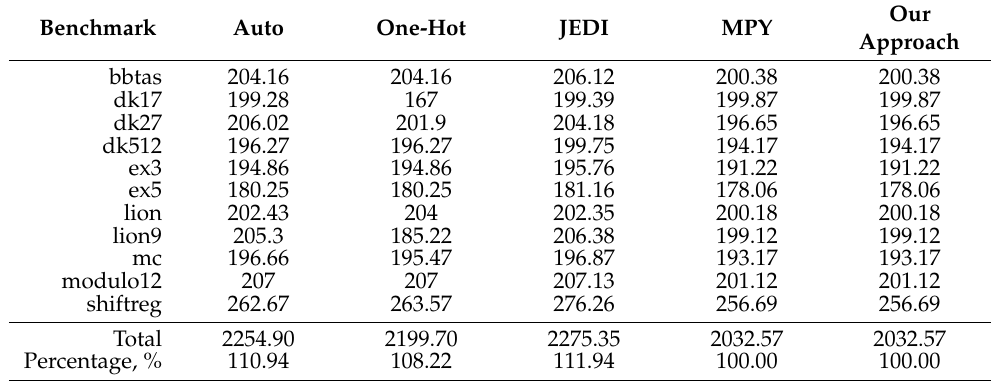
Table 14. Experimental results (the maximum operating frequency for BM1, MHz).